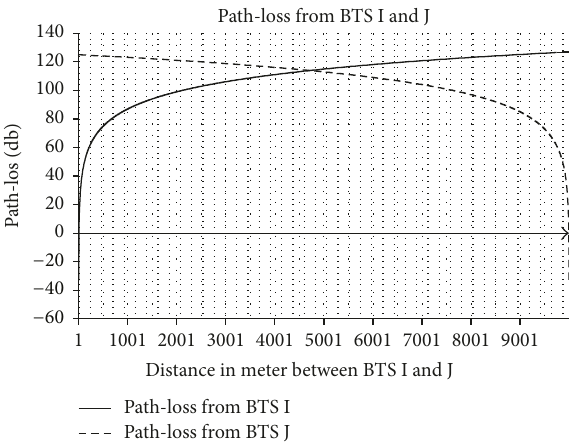
Figure 3: Path-loss from base stations I and J in db. Figure 4: SNR from base stations I and J db.